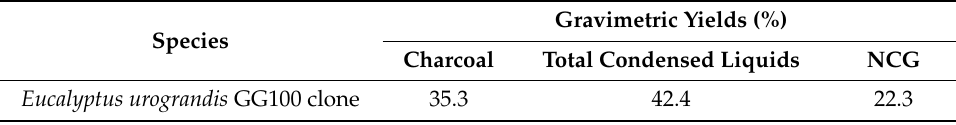
Table 1. Gravimetric yields from carbonization of Eucalyptus urograndis GG100 clone.